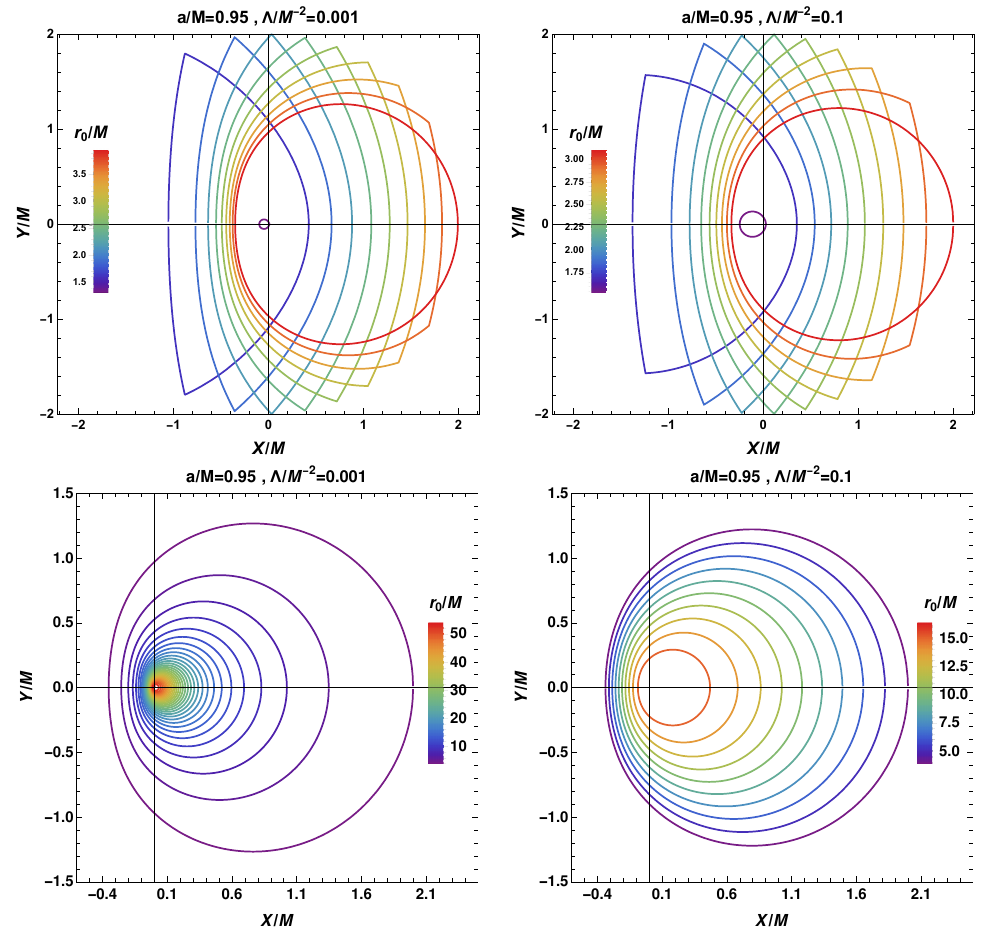
Figure 7. Shadow profile of new Kerr–de Sitter black holes with varying observer distance r NK + < r o < r + p ( upper panels ) and r + p < r o < r NK c ( lower panels